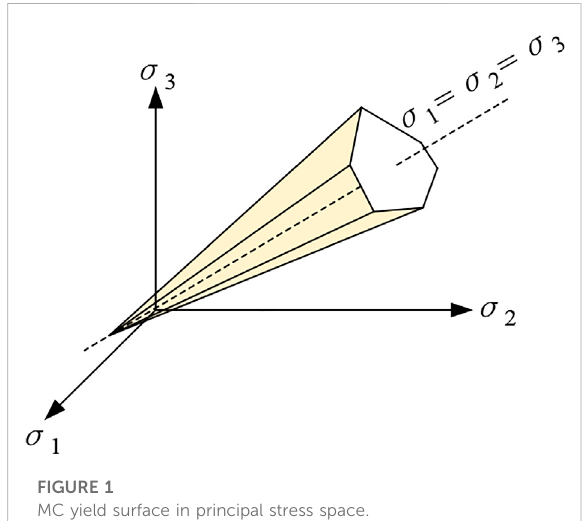
MC yield surface in principal stress